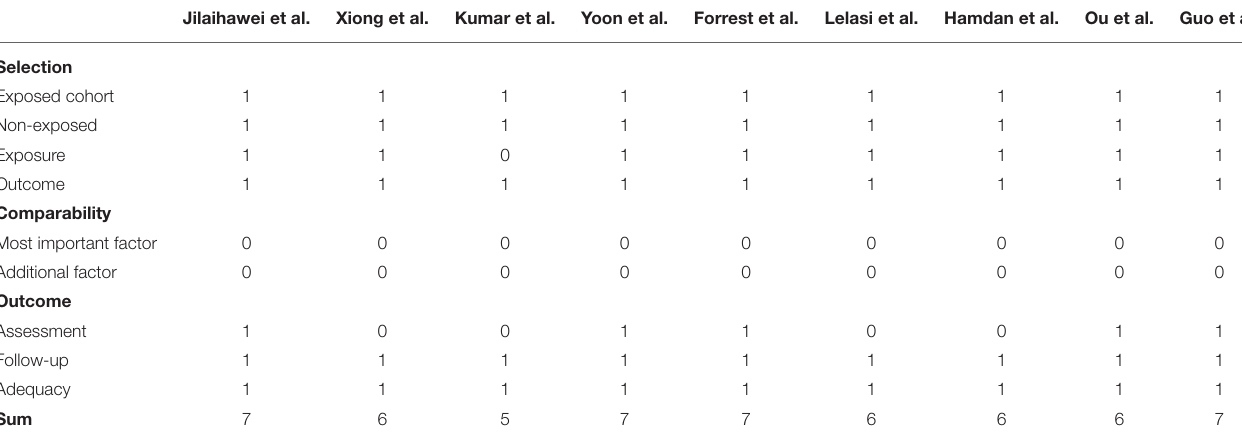
TABLE 1 | Quality assessment of eligible studies by Newcastle–Ottawa